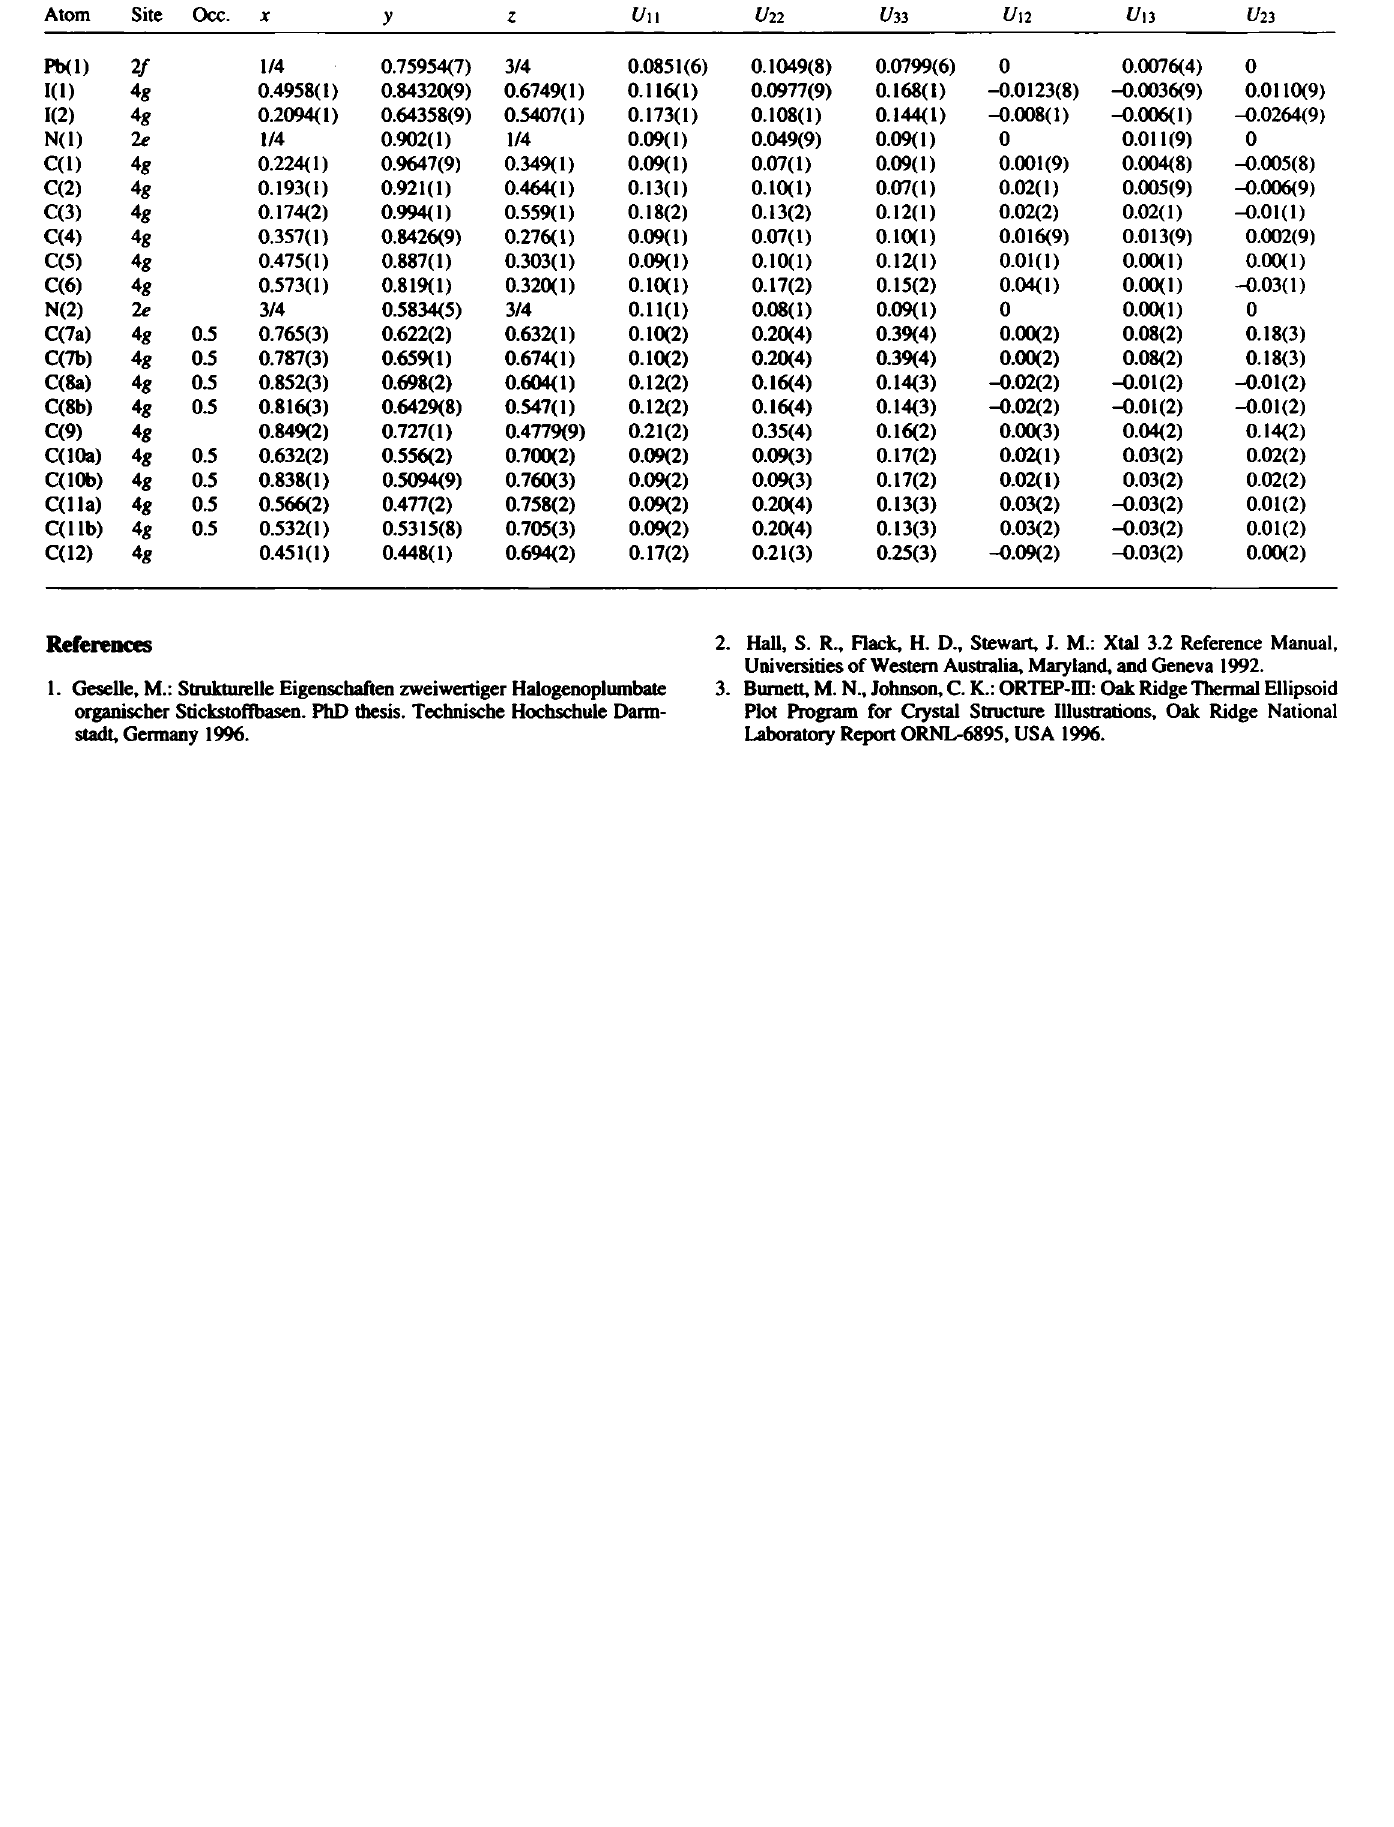
Table 3. Final atomic coordinates and displacement parameters (in Â 2 )